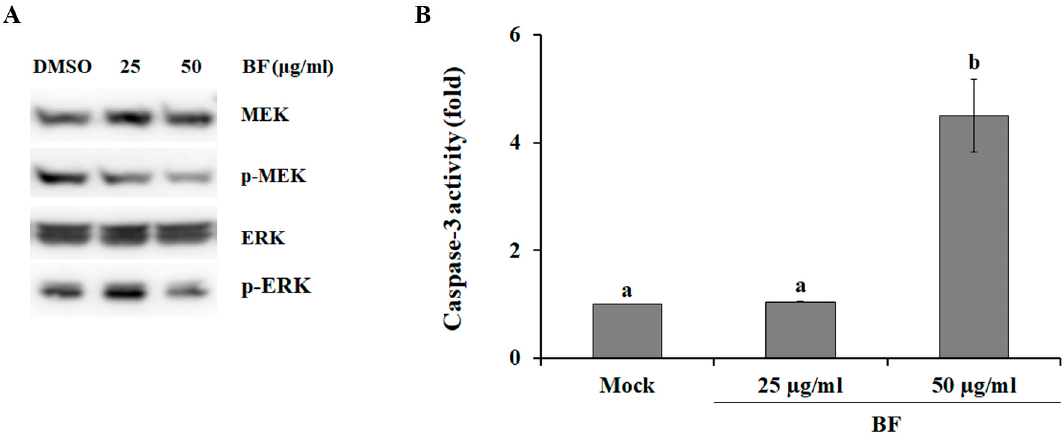
Figure 2. Molecular mechanisms of BuOH fraction (BF)-induced cytotoxicity against SK-MEL-2 cells. ( A ) Effect of the mitogen-activated protein kinase/extracellular regulated kinase (MEK/ERK) signaling pathway on BF-induced cell death. ( B ) Effect of BF on caspase-3 activity in SK-MEL-2 cells. All values are reported as the mean ± SE. DMSO treated samples served as mock. Mean separation within columns was determined via Duncan’s multiple range test at a 0.05% level.